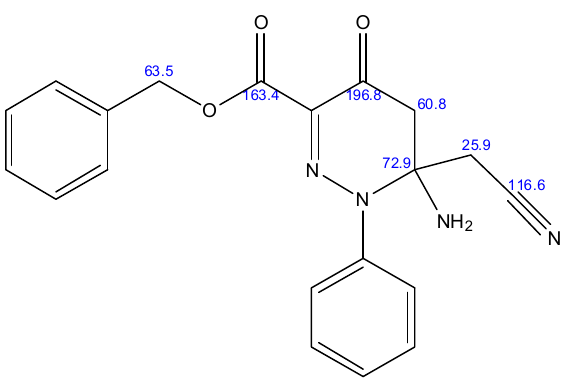
Figure 3. 13 C-NMR spectroscopic analysis of 13a .